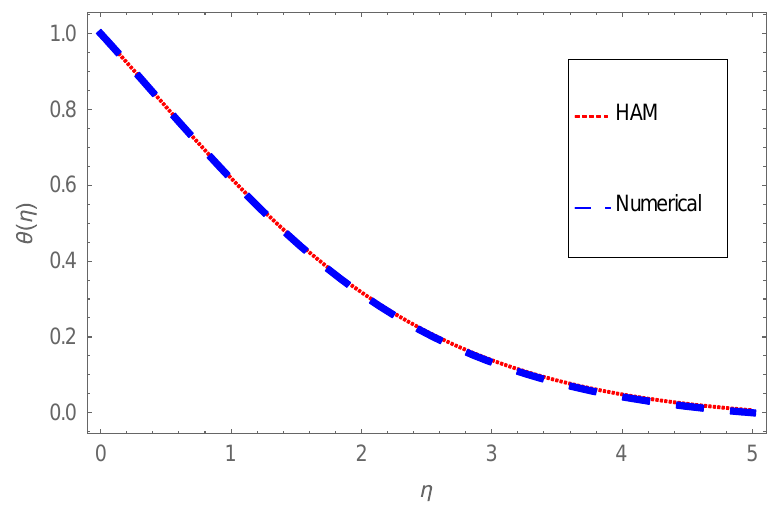
Figure 3. Dual solution for temperature field.